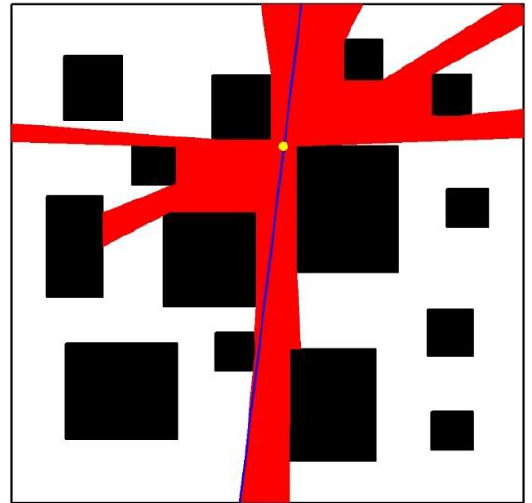
Figure 5. Isovist example in the artificial environment, where the black rectangles are the unnavigable areas, the yellow point is current position, the red area is the visibility area, and the blue line is the ridge, which is the longest line inside the visibility area.